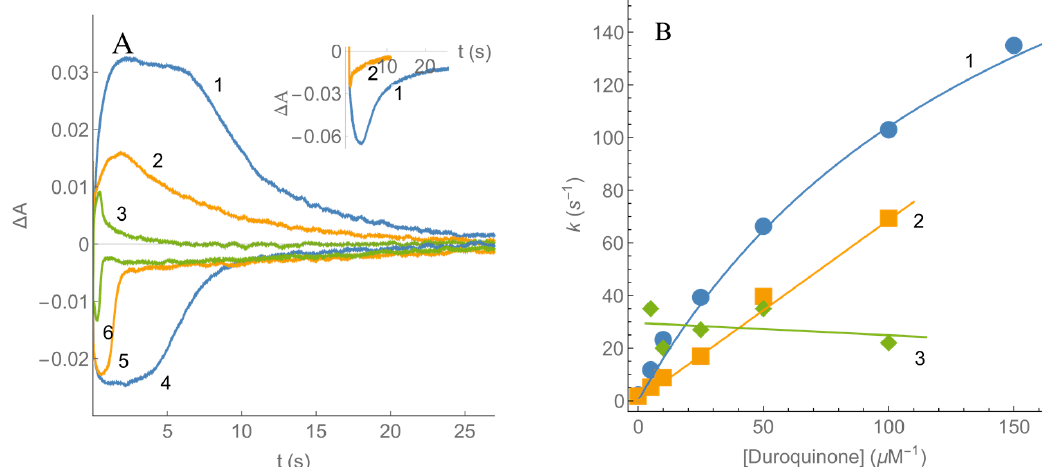
Figure 6. The kinetics of nNOS reduction and reoxidation under multiple turnover conditions in the presence of CAM, H 4 B and Arg. The concentrations of enzyme and compounds are given after mixing. ( A ) The spectral changes of 2.0 µ M nNOS monitored at 436 nm (1–3) and at 485 nm (4–6) during the reduction by 30 µ M NADPH and subsequent reoxidation by O 2 (1, 4) and by 5.0 µ M (2, 5) or 50 (3, 6) µ M duroquinone. The inset shows the kinetics of spectral changes at 397 nm in the absence (1) and in the presence of 100 µ M duroquinone (2). ( B ) Dependence of the apparent first order rate constants of reoxidation of reduced FAD-FMN (1), reoxidation of Fe 2+ -NO complex (2) and formation of Fe 2+ -NO complex (3) on duroquinone concentration.